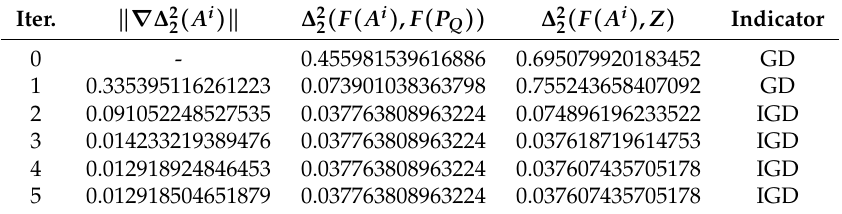
Figure 17. Different iterations of the ∆ 2 bootstrapping method. Table 11. Numerical results of the ∆ 2 bootstrapping